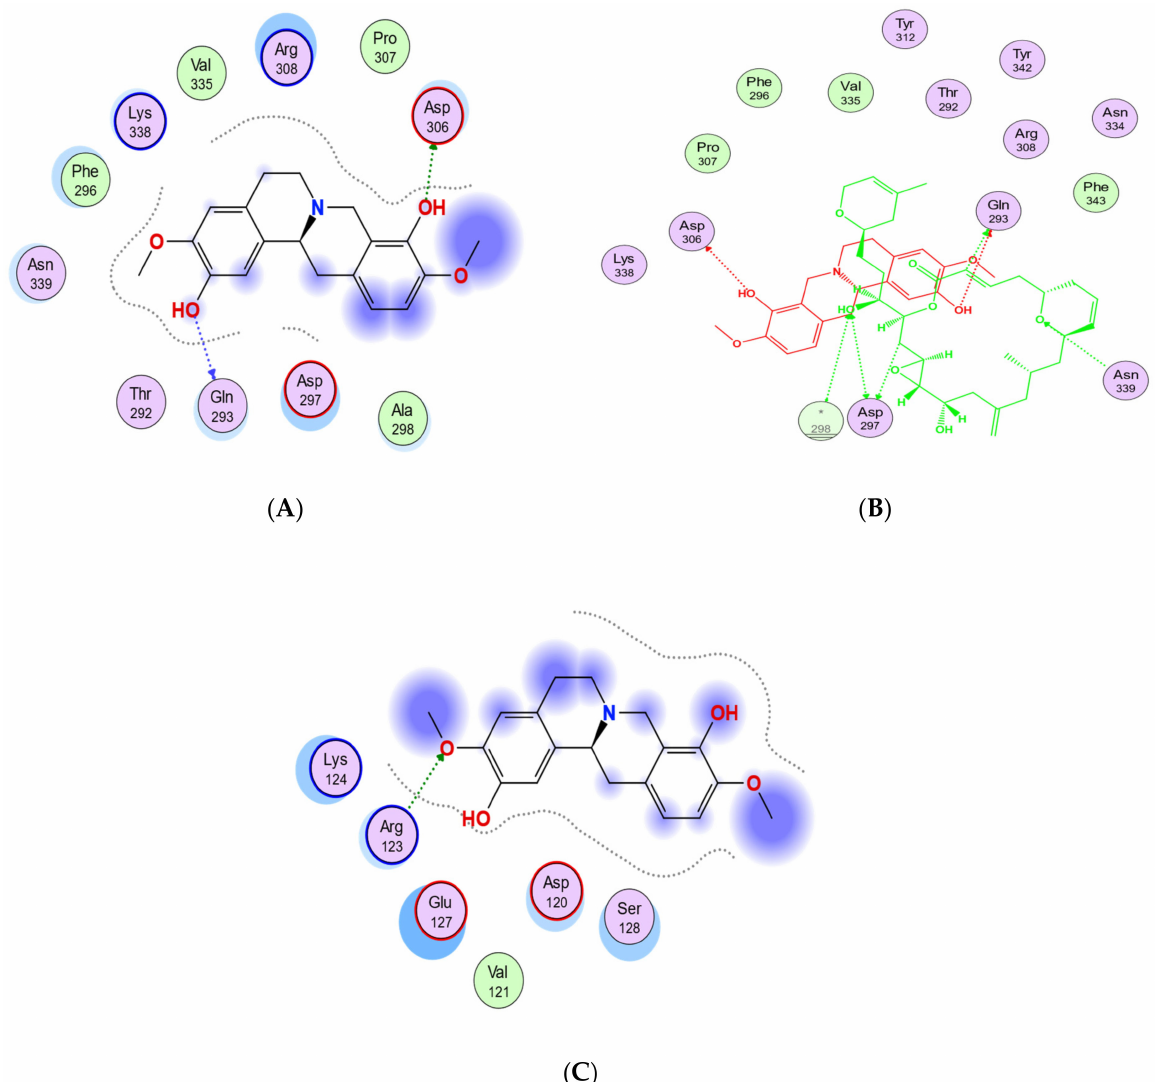
Figure 11. ( A ) Two-dimensional interaction scheme of scoulerine in the S 2 site identified by blind docking. ( B ) Two-dimensional interaction scheme of the superimposed laulimalide crystal structure based on the 4O4H PDB file (green) with scoulerine (red) in the S 2 site on 1SA0. Star (*) on residue 298 indicates two different amino acids on 4O4H and 1SA0 structures. ( C ) Two-dimensional interaction scheme of scoulerine in the S 3 site found via blind